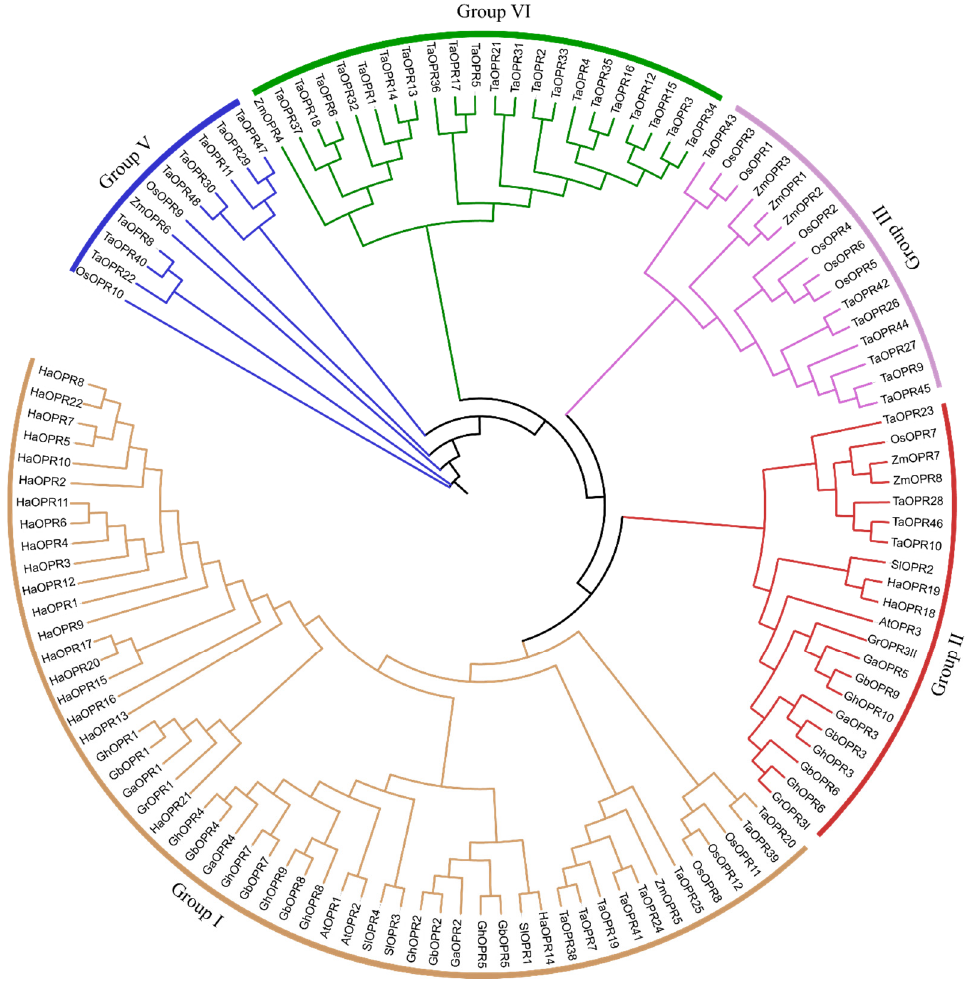
Figure 1. The maximum likelihood (ML) phylogenetic tree of the 12-oxo-phytodienoic acid reductase ( OPR ) family. The tree was drawn with the full-length amino acid sequences of OPR genes from Arabidopsis thaliana (Linn.) Heynh. (At), Gossypium arboreum L. (Ga), G. barbadense L. (Gb), G. hirsutum L. (Gh), G. raimondii Ulbr. (Gr), Helianthus annuus L. (Ha), Oryza sativa L. (Os), Solanum lycopersicum L. (Sl), Triticum aestivum L. (Ta), and Zea mays L. (Zm), using MEGA X, with 1000 replicates. They were classified into five groups. Group I, Group II, Group III, Group VI, and Group V are represented by orange, red, purple, green, and blue,